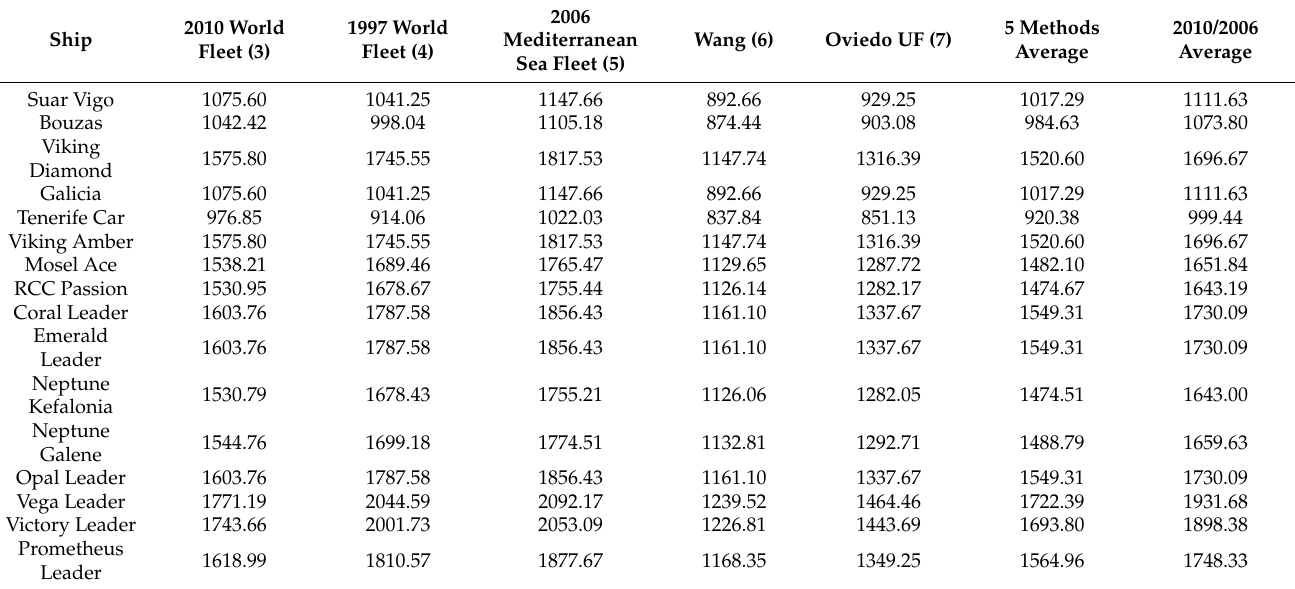
Table 10. Auxiliary engines’ consumed power (kW) estimate considering load factor of